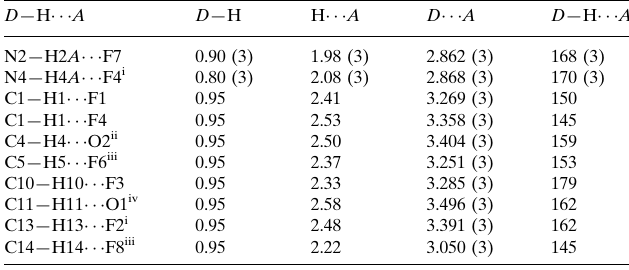
Hydrogen-bond geometry (A˚ , (cid:3)